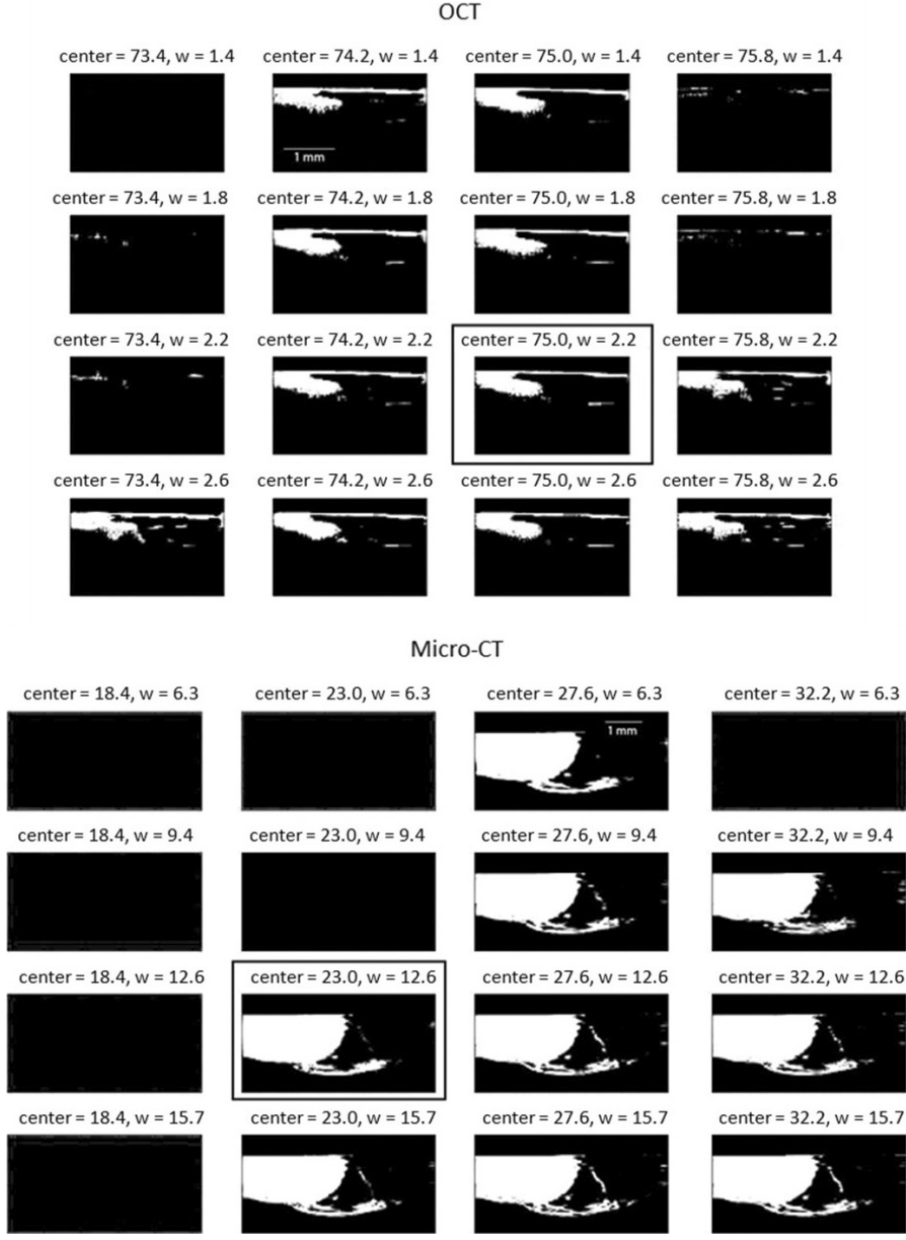
Fig. 3. Optimization of spatial frequency ¯ltering. In both sets of OCT and micro-CT images, the tumor tissue is located on the left. The center spatial frequencies vary in the range of 73.4 (cid:1) 75.8 cycles/mm from left-to-right for OCT and 18.4 (cid:1) 32.2 cycles/mm from left-to-right for micro-CT. The bandwidth varies in the range 1.4 (cid:1) 2.6 cycles/mm from top-to-bottom for OCT and 6.3 (cid:1) 15.7 cycles/mm from top-to-bottom for micro-CT. The optimal set of parameters has a center spatial frequency of 74.9 cycles/mm and a bandwidth of 2.2 cycles/mm for OCT, and a center spatial frequency of 23.01 cycles/mm and a bandwidth of 12.3 cycles/mm for micro-CT